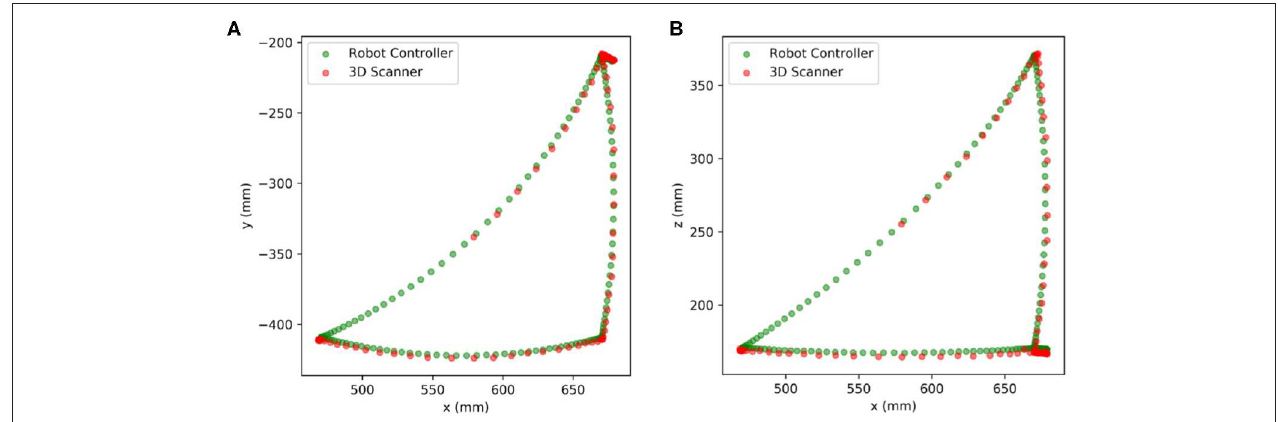
FIGURE 5 | Trajectory tracking of the TCP center with moveJ. (A) In x-y plane (B) In x-z plane.